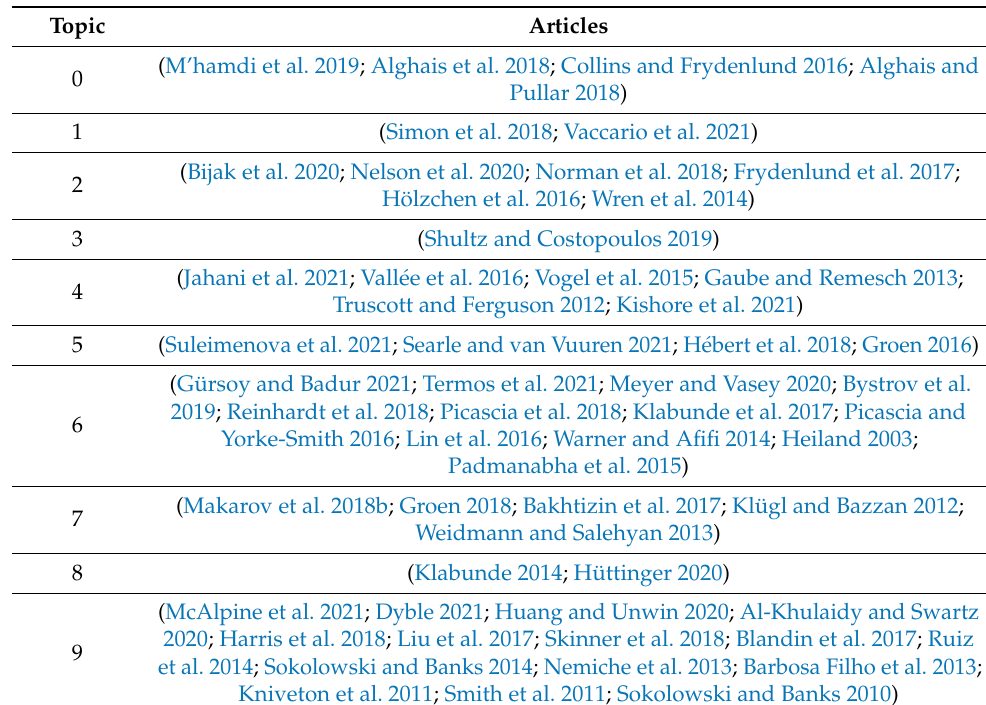
Table 6. Strongest associations between topic and articles in the LDA